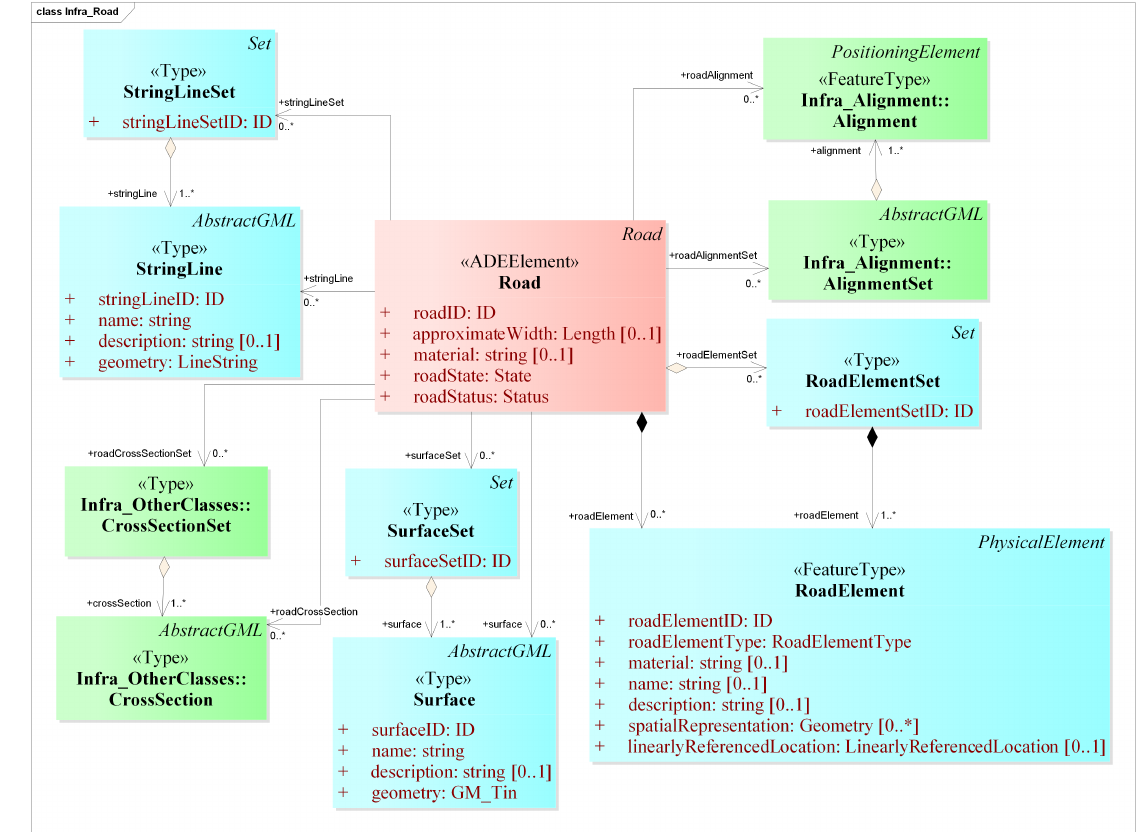
Figure 3. The UML excerpt depicts existing CityGML class CG::Road (marked with stereotype «ADEElement») extended to include attributes and classes from LandInfra LI::Road class in the CityGML Infra